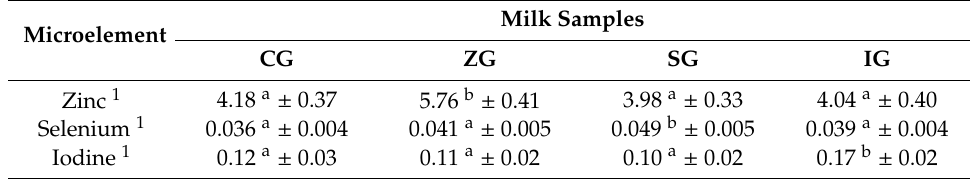
Table 1. Microelements quantification in milk samples obtained from lactating dairy cows fed control diet (CG) and control diet supplemented with zinc (ZG), selenium (SG), and iodine (IG).